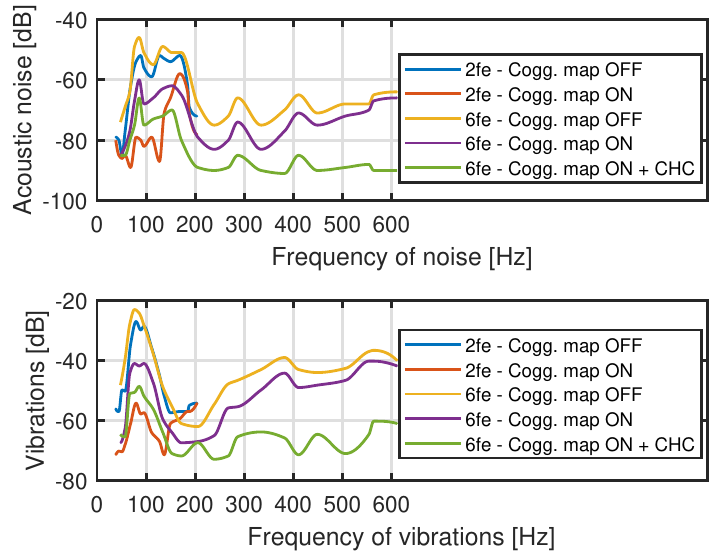
Figure 28. Acoustic noise and vibrations (2 f e curve and 6 f e curve) vs. their own frequency.